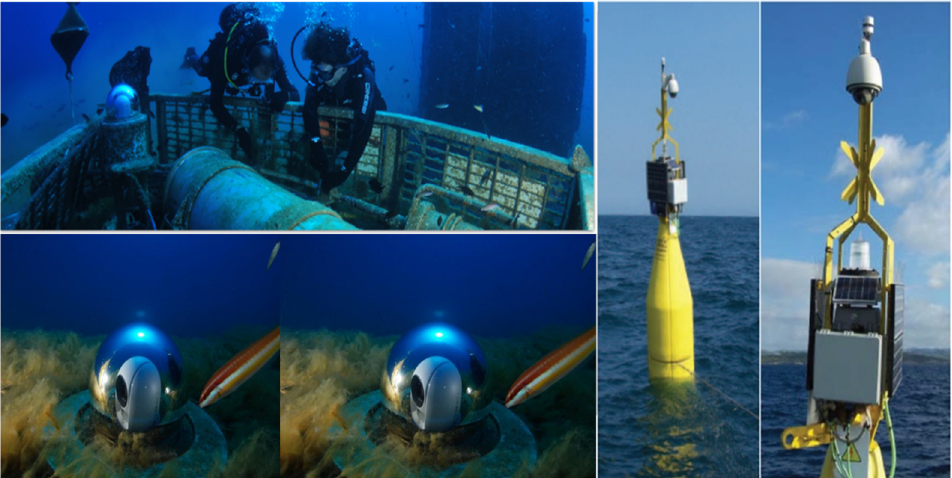
Figure 3. Photographs of the installation of the OBSEA wired observatory and the surface buoy: Divers performing maintenance operations; azimuth view of the position of the observatory with respect to an artificial biotope; detail of the underwater camera; surface buoy.